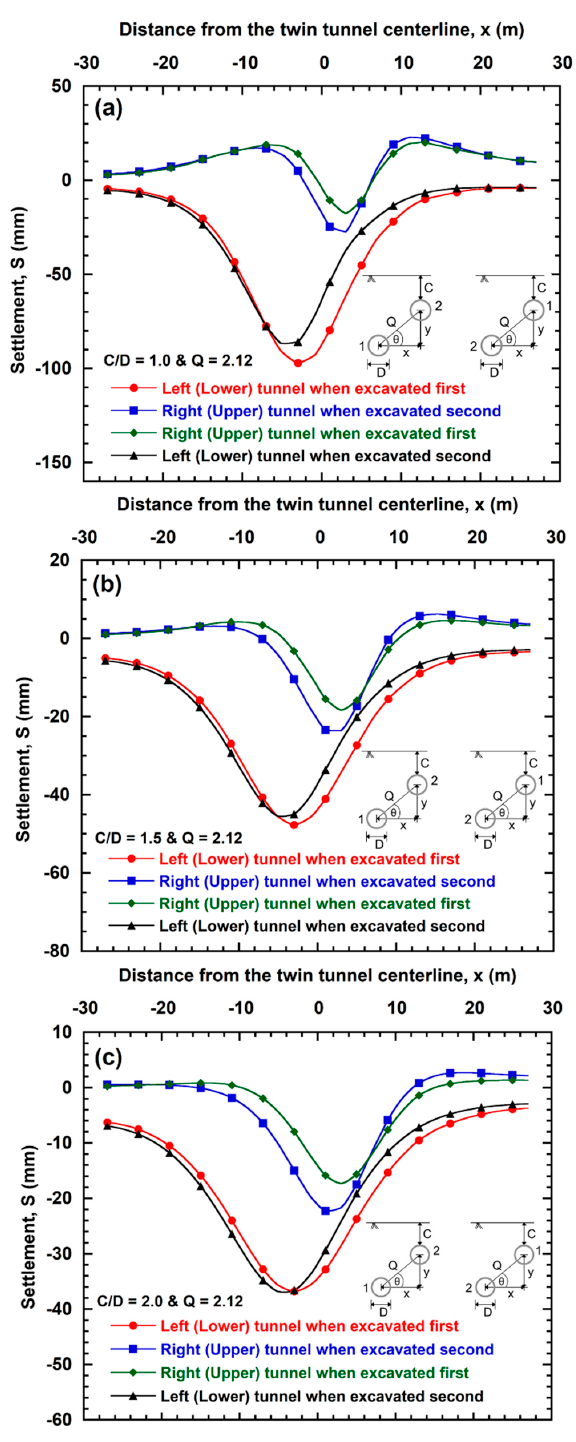
Figure 16. Individual surface vertical settlement induced by both first and second tunnels during staggered excavation of offset arrangement twin tunnels ( a – c ). Total settlement induced from the excavation of twin tunnels for three C / D ratios and for three excavation sequences are shown in Figure 17a–c. The relationship between the maximum observed soil settlement and C / D ratios is summarized in Figure 17d. It